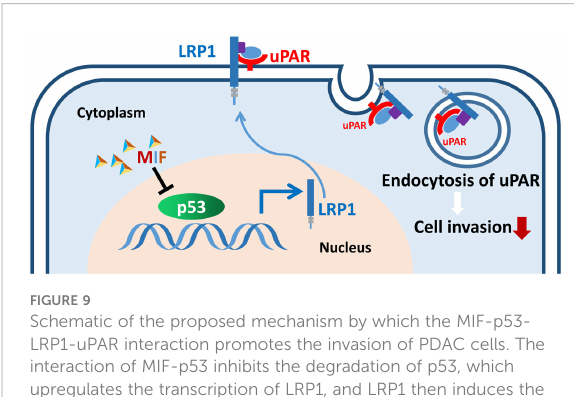
FIGURE 9 Schematic of the proposed mechanism by which the MIF-p53- LRP1-uPAR interaction promotes the invasion of PDAC cells. The interaction of MIF-p53 inhibits the degradation of p53, which upregulates the transcription of LRP1, and LRP1 then induces the internalization of uPAR and consequently weakens cell